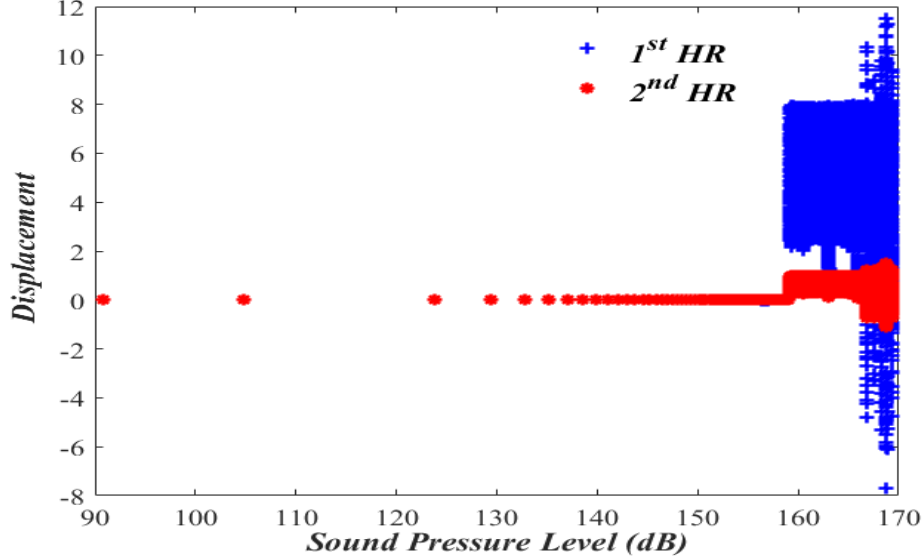
Figure 3. Bifurcation diagram for a nonlinear dual HR (Case II). Note that the 1st and the 2nd HRs have the same displacement before the chaotic response.